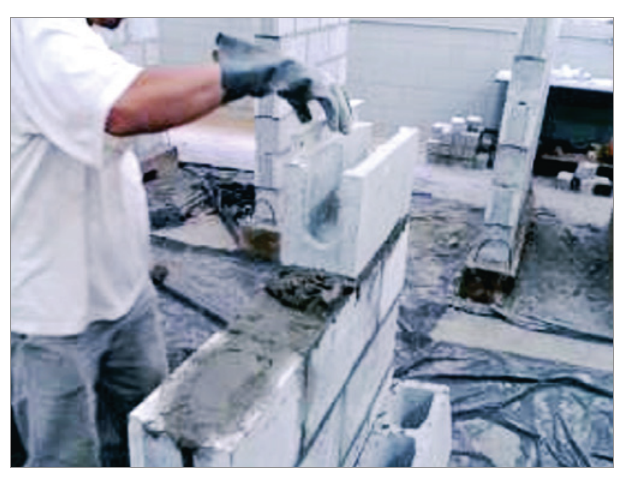
Sequência de montagem das paredes